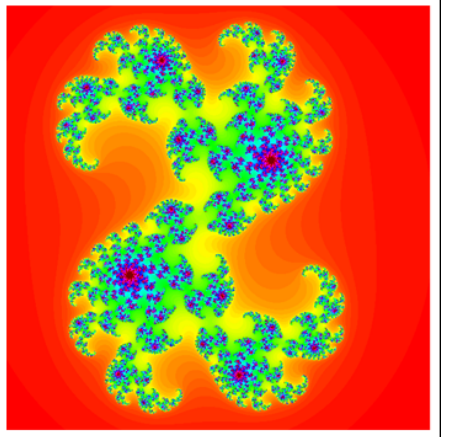
Figure 4. Second degree J-set via F-iteration with image visual time = 54.45 s.